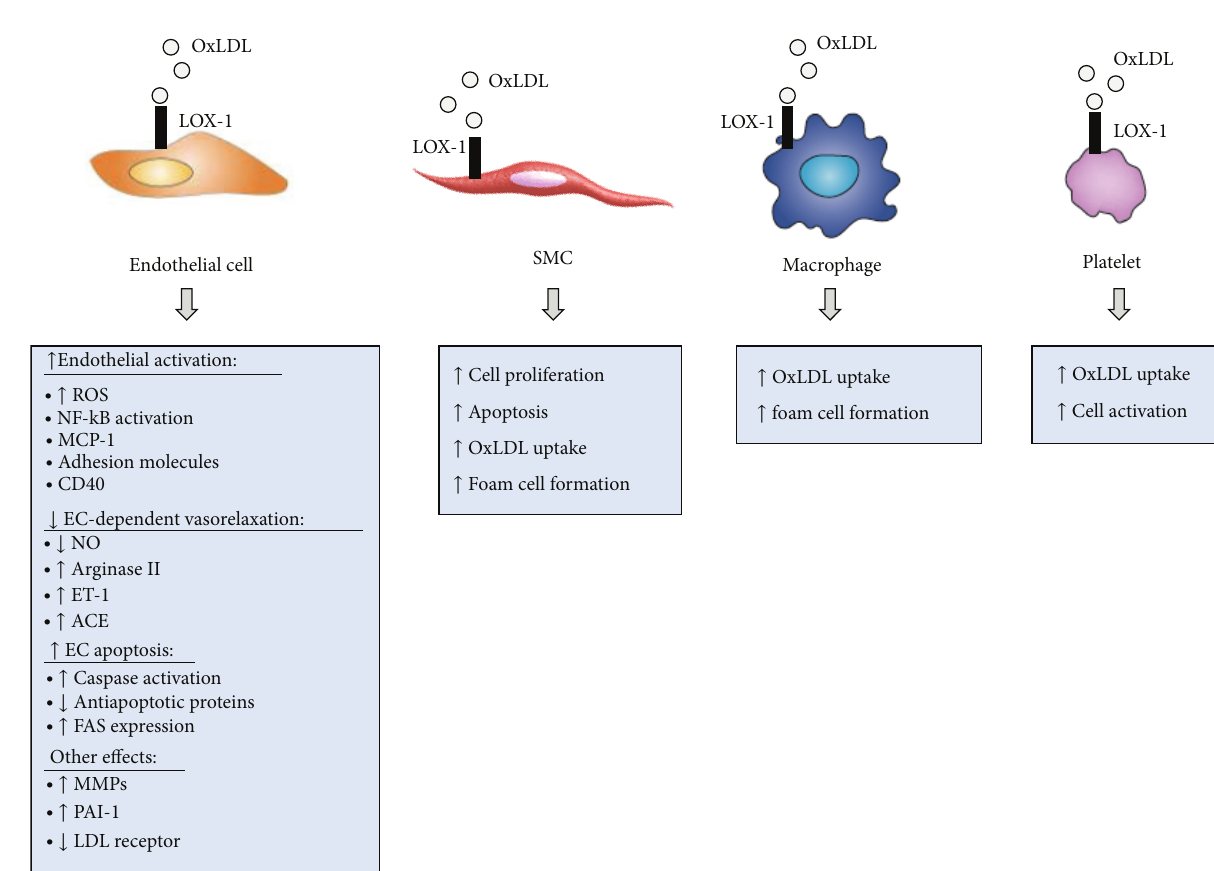
Figure3:RoleofLOX-1inatherosclerosis.OxLDLbindingtoLOX-1inducesendothelialactivationanddysfunction,supportstherecruitment of circulating leukocytes, triggers foam cell formation, and sustains migration and proliferation of smooth muscle cells, thus contributing to the development of the atherosclerotic plaque. Furthermore, OxLDL-LOX-1 interaction may also contribute to plaque destabilization by inducing smooth muscle cell apoptosis and the release of matrix degrading enzymes